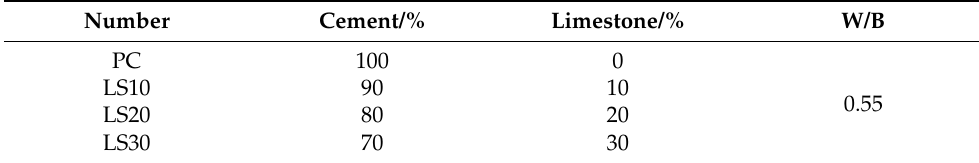
Table 2. Mixing proportions of the cement pastes.